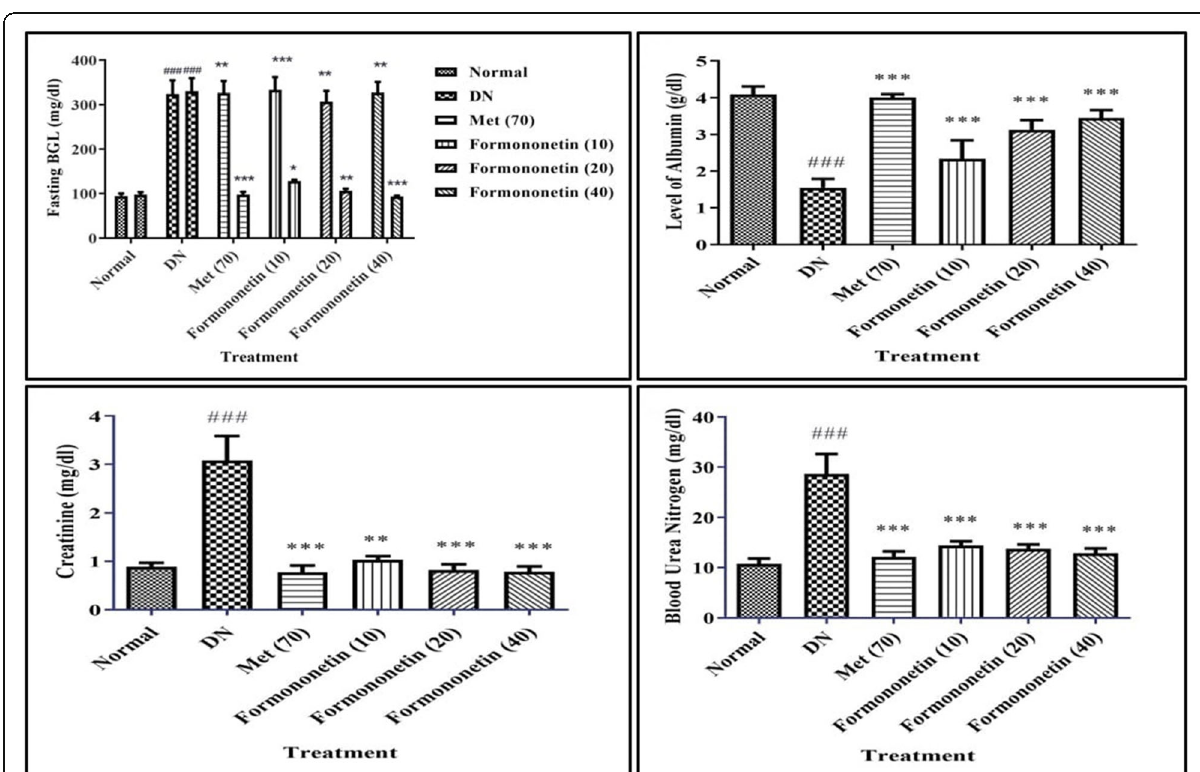
Fig. 3 Effect of formononetin on serum biochemical parameter. Data were presented as mean ± S.E.M. (n-6). The result values were statistically analyzed by using one-way ANOVA and two-way ANOVA followed by Bonferroni ’ s test for multiple comparisons.